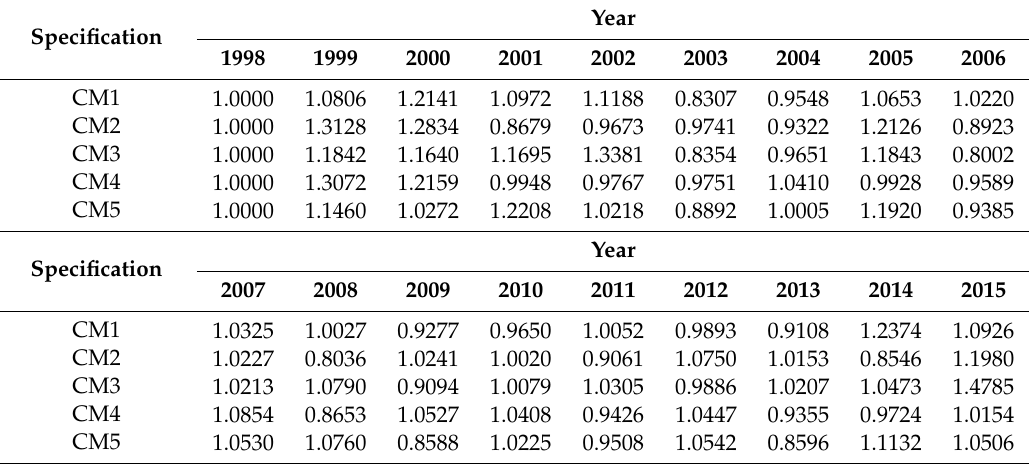
Table 6. Chain indices of dynamics in examined coal mines (CM) in 1998–2015.